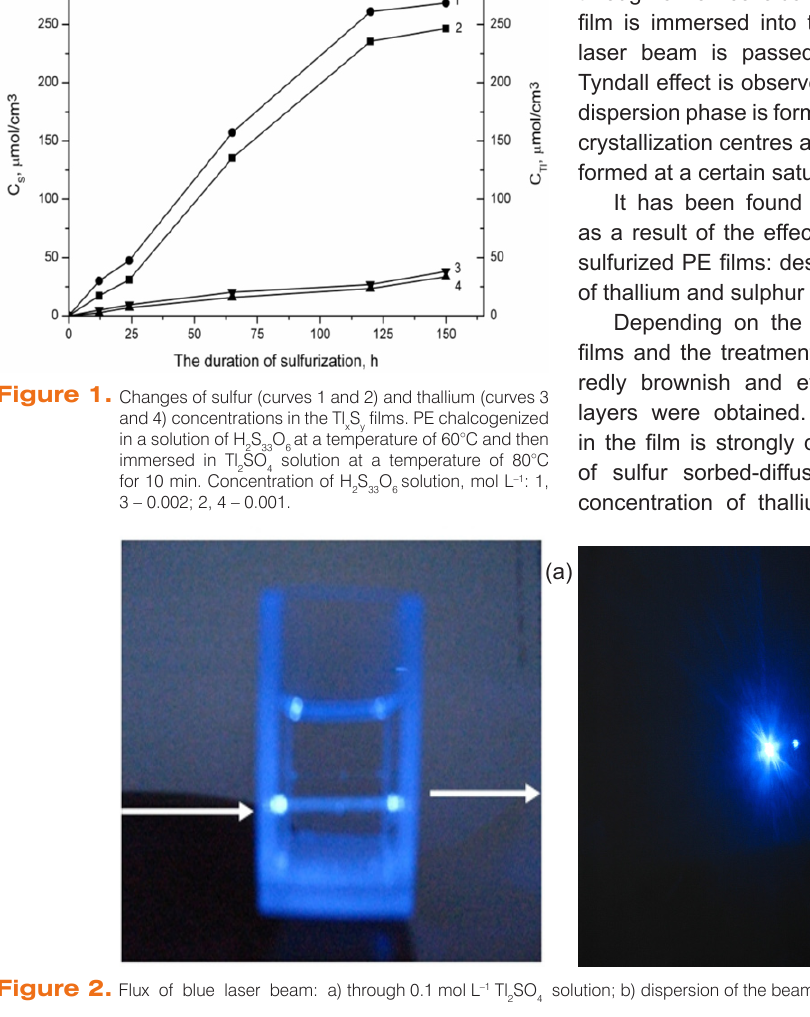
SO solution; b) dispersion of the beam. 2 4